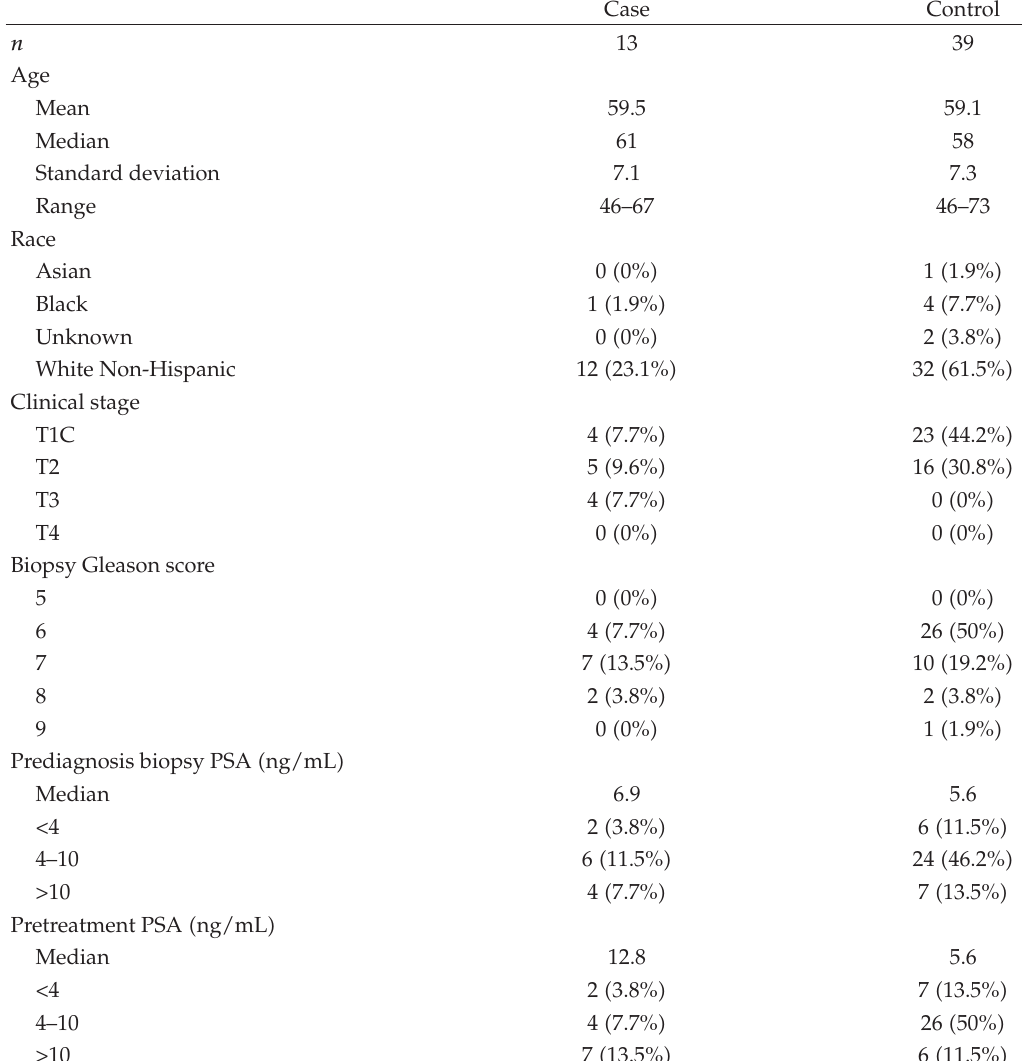
Table 1: Clinical And histological characteristics of samples used to validate the metastatic potential score model.